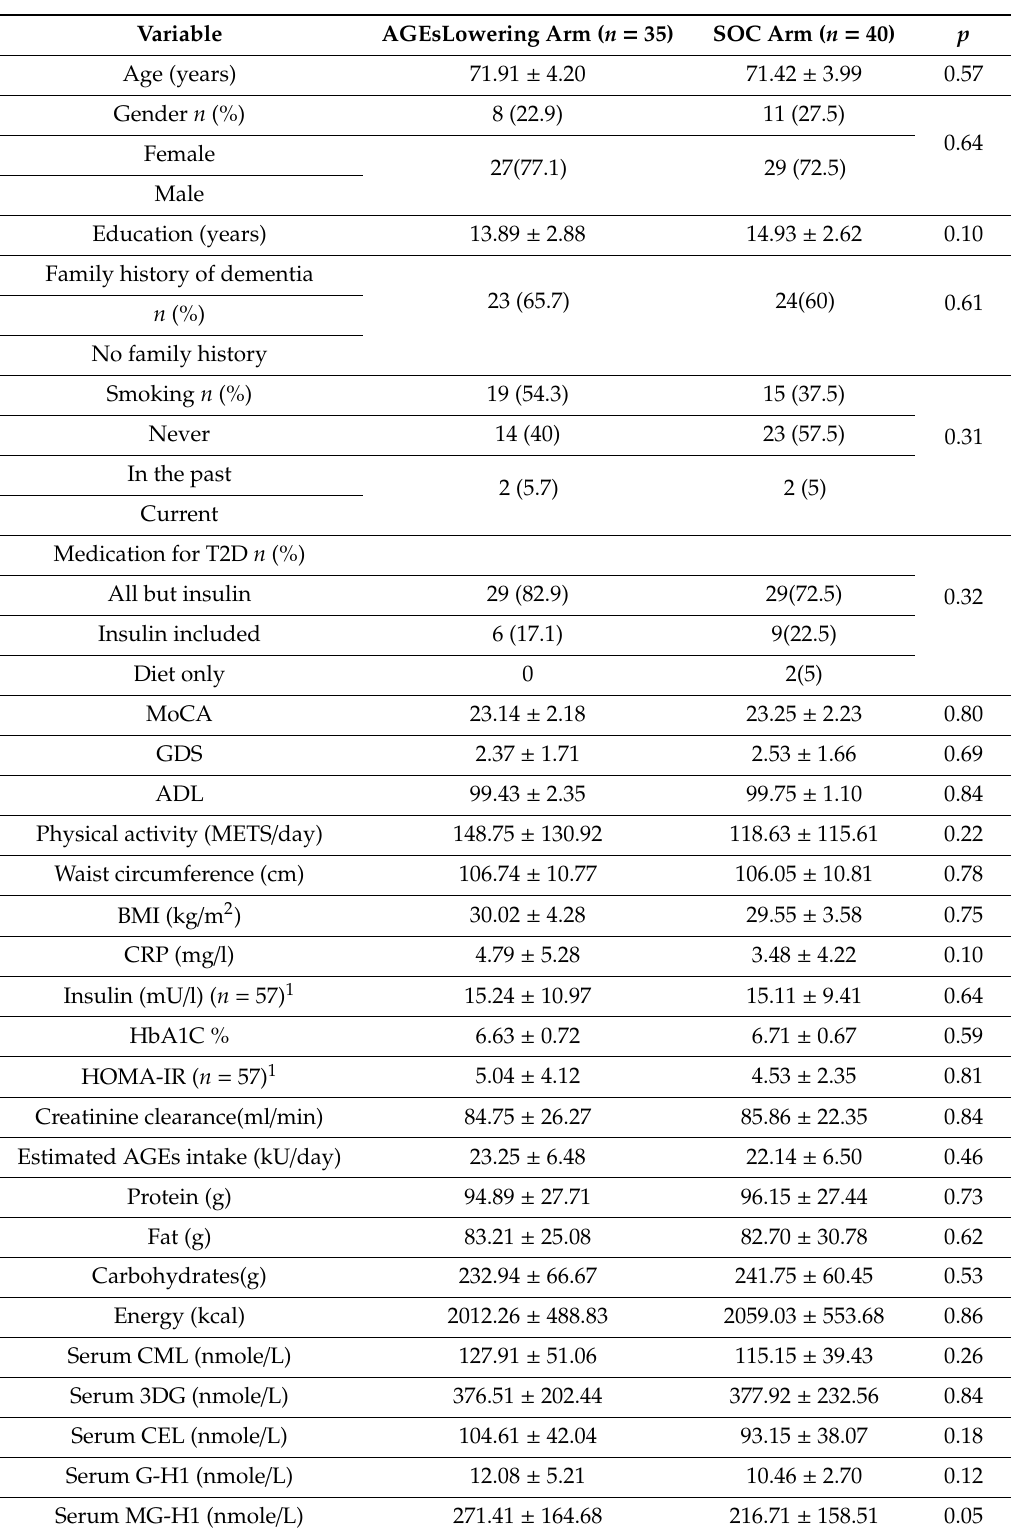
Table 1. Baseline characteristic ( n =